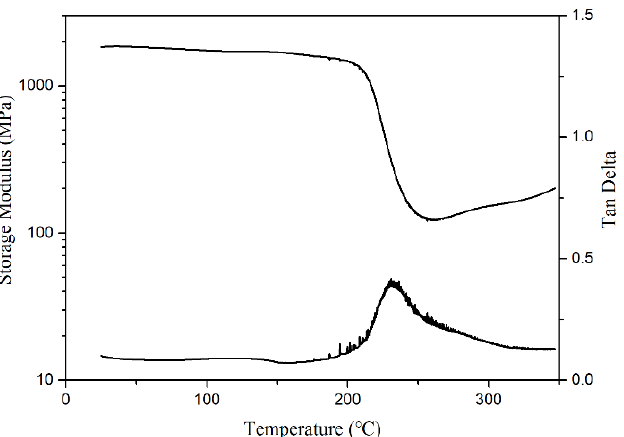
Figure 7. Thermomechanical behavior of p(T–Fa) by dynamic mechanical thermal (DMA) analysis.